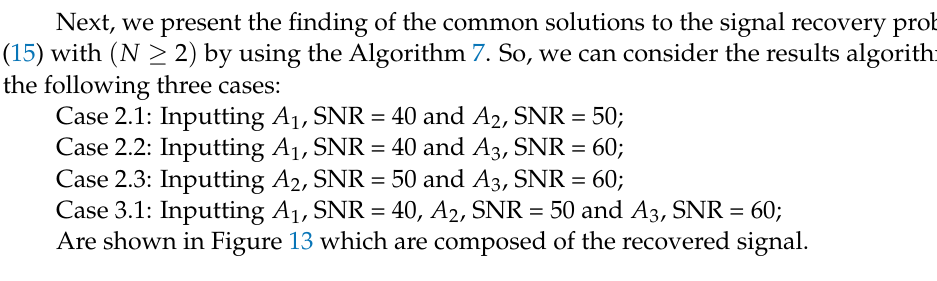
Figure 12. Recovered signal by Case 1.1, Case 1.2 and Case 1.3, respectively.